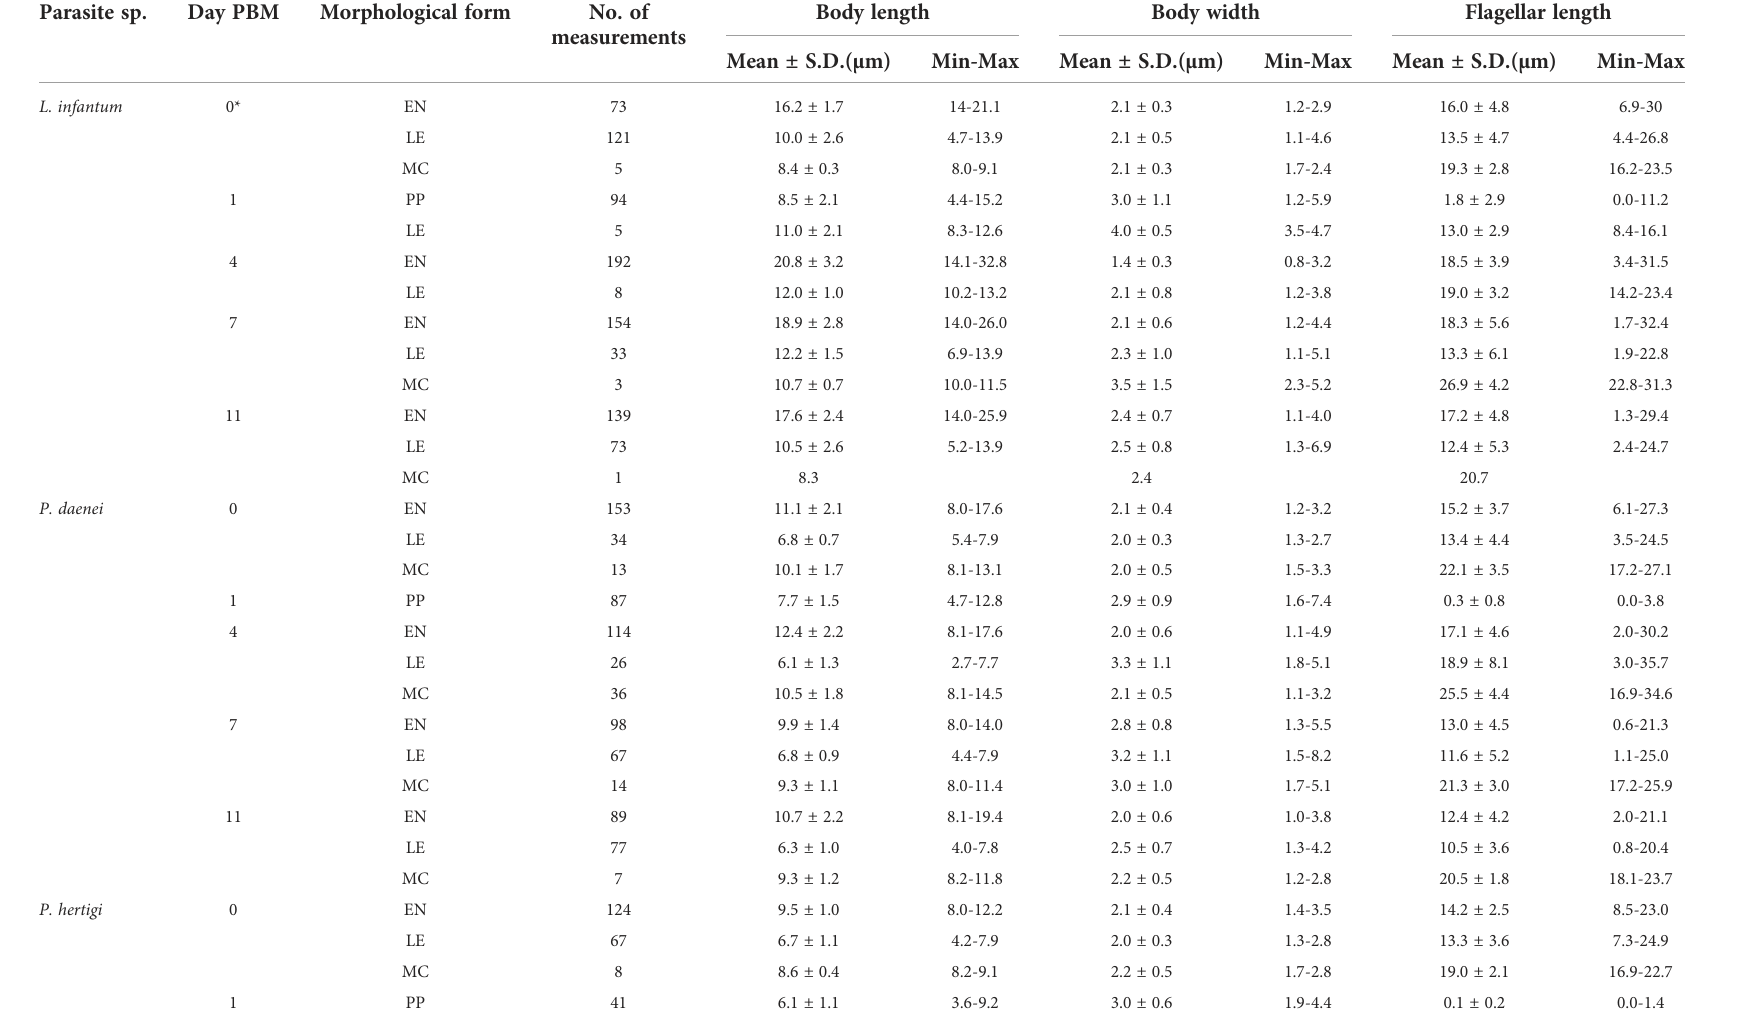
TABLE 1 Measurements of morphological forms from gut smears of L. longipalpis . Parasite